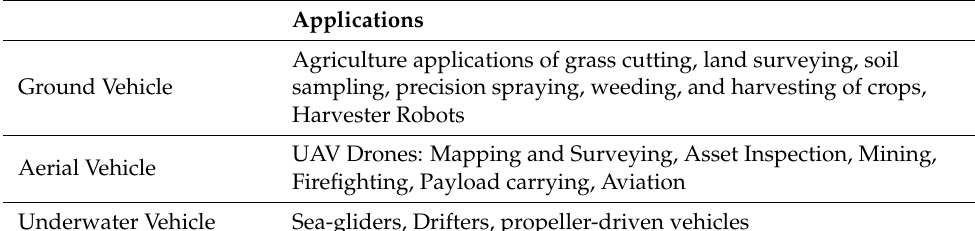
Figure 3. Available Methods for Ground Robotics. Table 2. Applications involved in different Vehicle